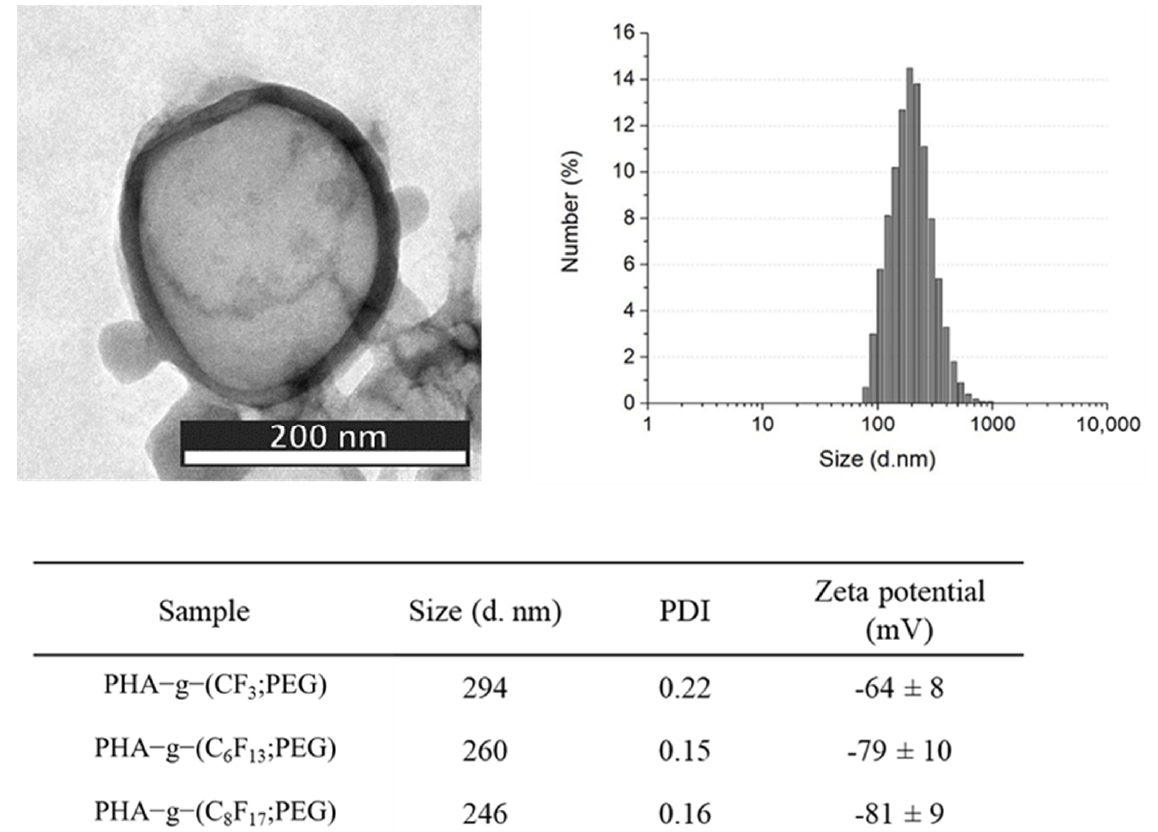
Figure 8. Characterization of nanocapsules by TEM and DLS.